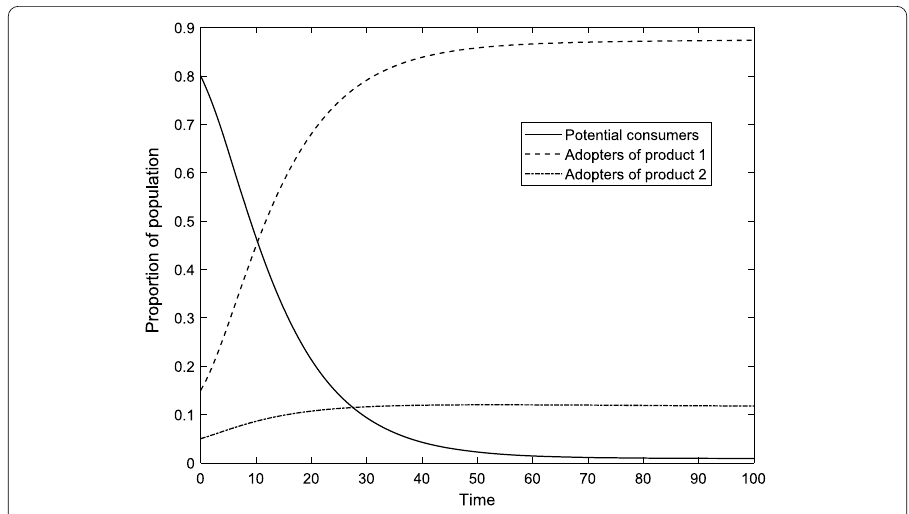
Figure 2 Two competitive products coexist and persistently diffuse without considering advertising